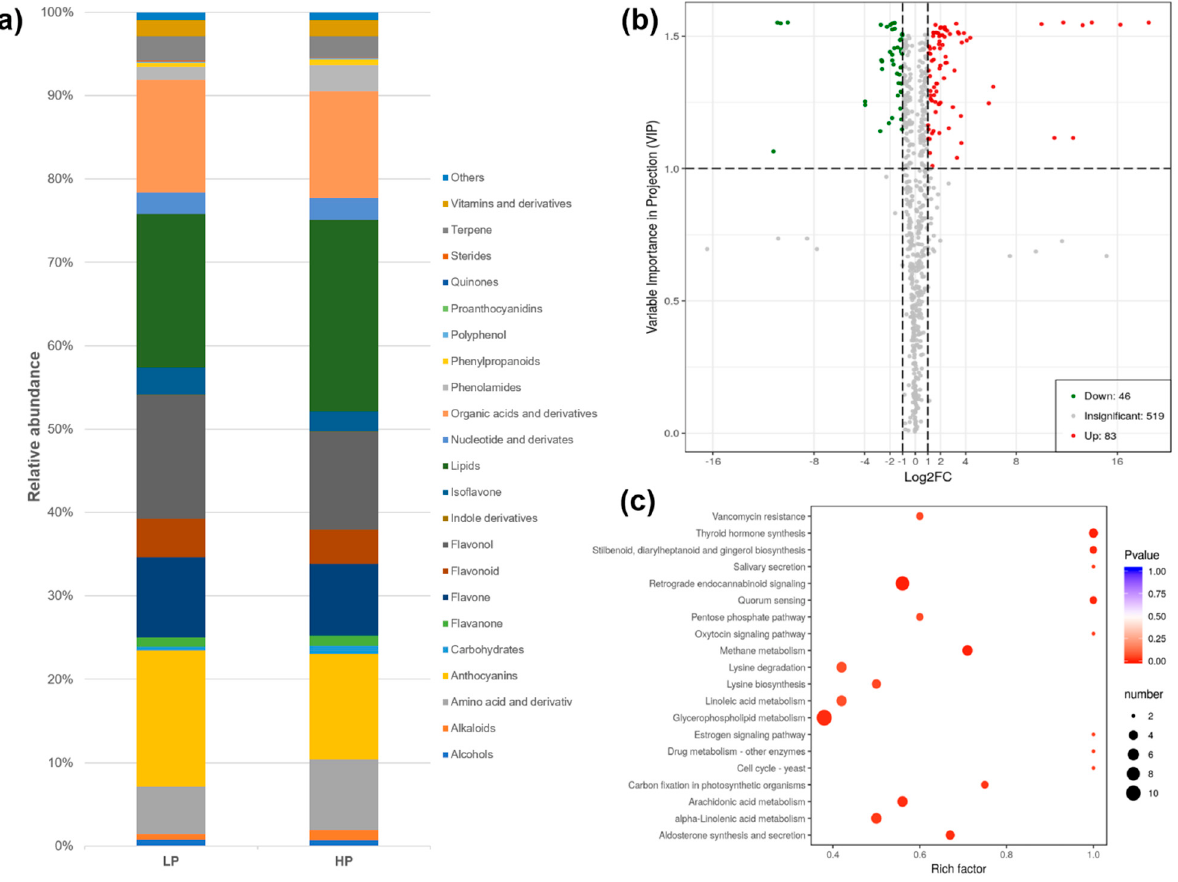
Figure 4. Metabolite categories of white clover roots grown under a high (HP) or low phosphorus (LP) treatment ( a ), differentially accumulated metabolites (LP versus HP) ( b ) and their KEGG annotations ( c ).